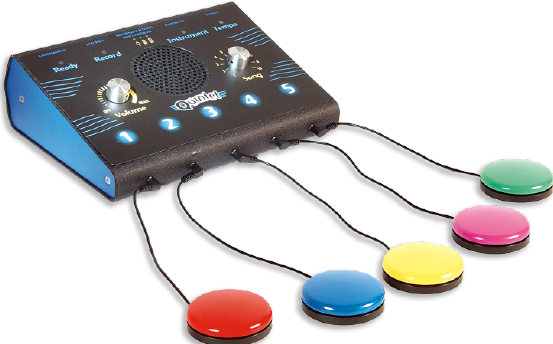
Figure 2. Quintet , a musical instrument that allows connection of up to five standard accessibility switches